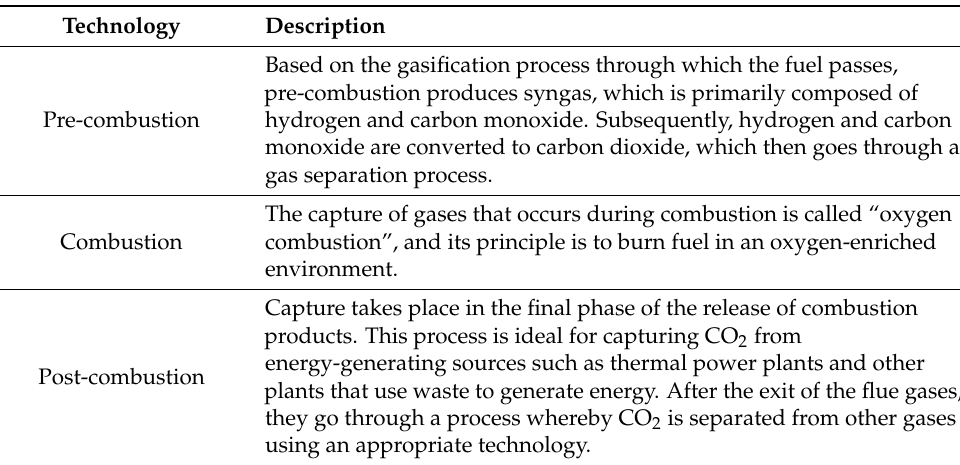
Table 2. CO 2 utilization